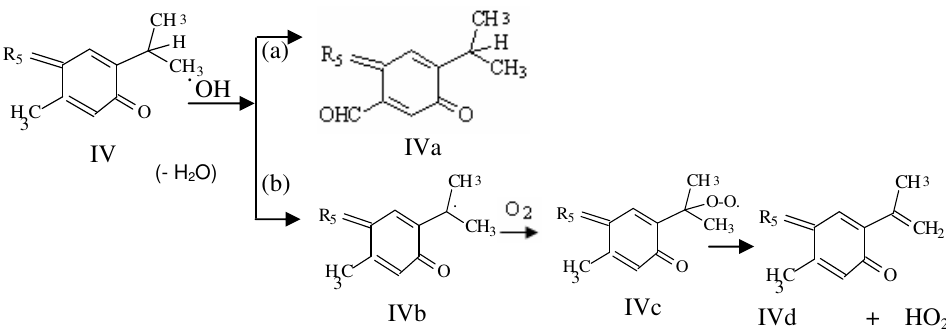
Figure 6 . The degradation route of the segment